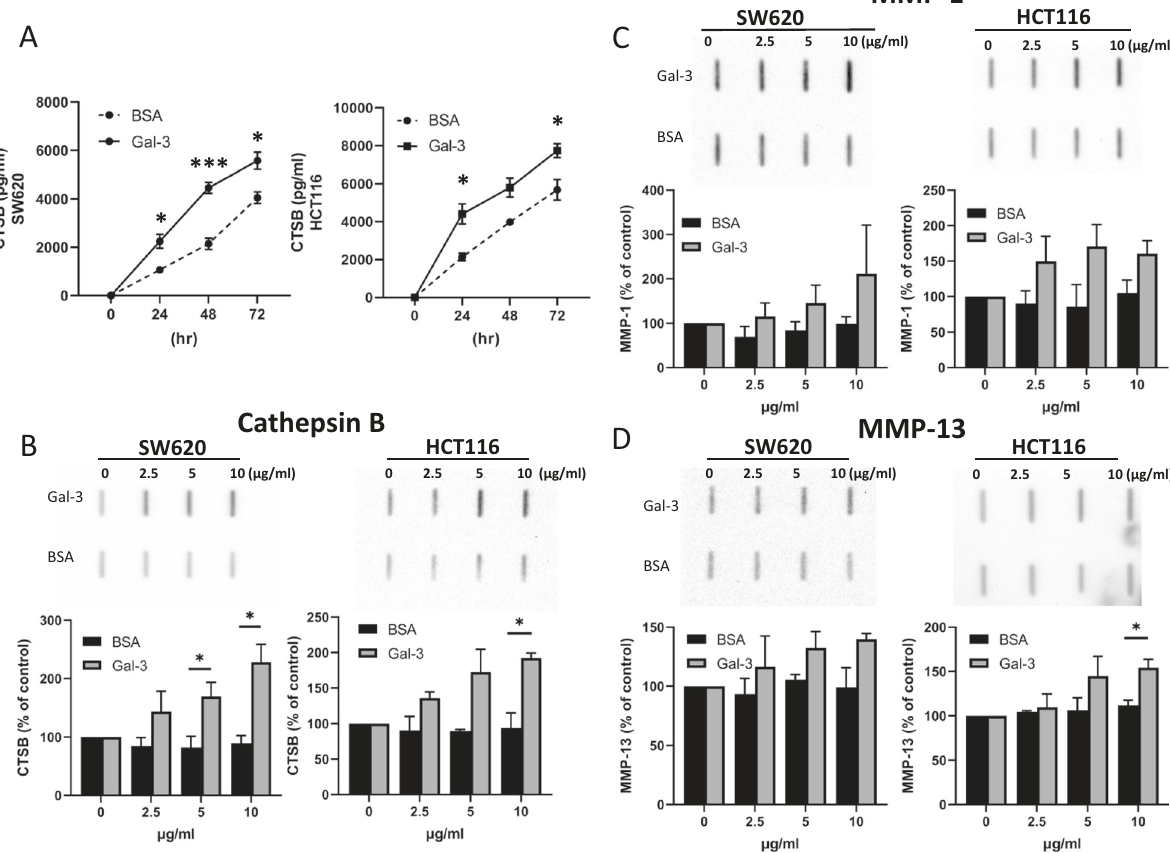
Fig. 2 Galectin-3 induces protease secretion in human colon cancer cells in a dose- and time-dependent manner. SW620 and HCT116 cells were treated with galectin-3 or BSA (10 µg/ml) for different times before the concentrations of Cathepsin-B were analysed ( A ) by ELISA. SW620 and HCT116 cells were treated with different concentrations of galectin-3 for 24 h ( B – D ) before the levels of Cathepsin-B ( B ), MMP-1 ( C ), MMP- 13 ( D ) in the medium were analysed by slot blotting. The slot densities from three independent experiments were quanti fi ed and are shown in the bottom panels. Data are presented as mean ± SD of three independent experiments, each in triplicate. *** P < 0.001, * P < 0.05